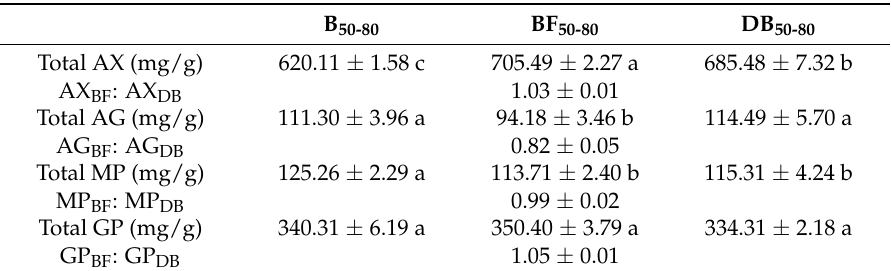
Table 4. Total AX and ratio in BF vs. DB after gradient